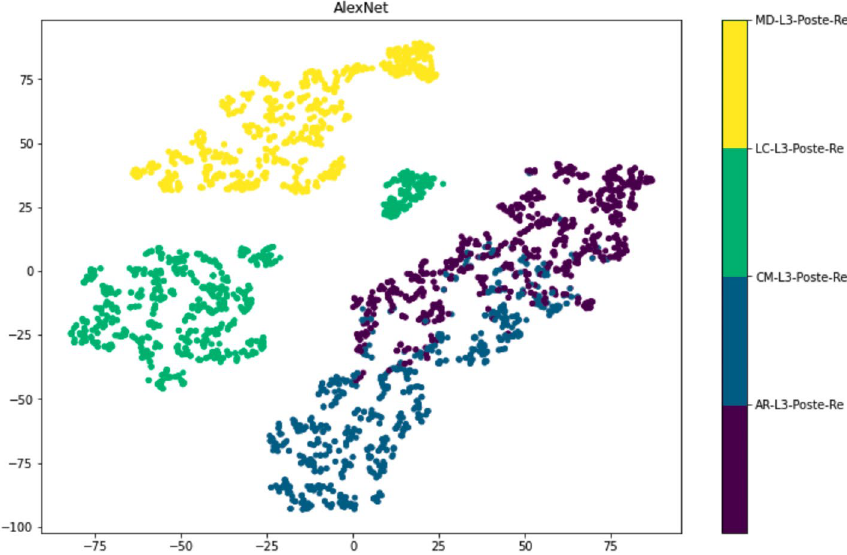
Figure 3. tSNE visualization of the AlexNet model by dimensionality reduction of the penultimate features (The test data are shown in colors for different classes; yellow refers to data set of Musca domestica , green refers to data set of Lucilia cuprina , greenish blue refers to data set of Chrysomya megacephala , and dark purple refers to data set of Chrysomya ( Achoetandrus ) ruffifacies